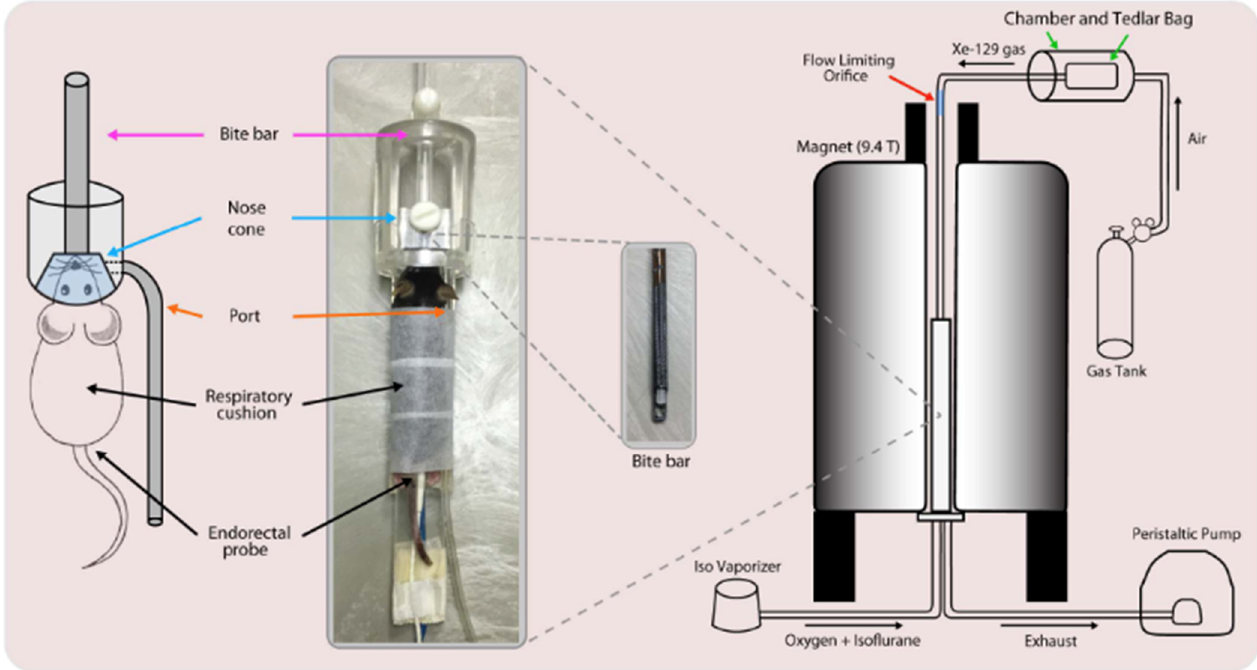
Figure 33. ( Left ) Mice were held in an animal cradle consisting of a bite bar to adjust the animal’s position, and a nose cose through which gas is supplied. The port was used as an exhaust for exhaled gas. ( Right ) O 2 , air, and isoflurane were supplied from beneath the bore, while HXe was supplied from above through the bite bar: the gases mix within the nose cone, supplying the animal with a normoxic gas micture. Exhaled gas and isoflurane were passed through a peristaltic pump and isoflurane scrubber. Reprinted with permission from Loza, et al. ( IEEE Trans Med Imaging 2019, ref. [57]).